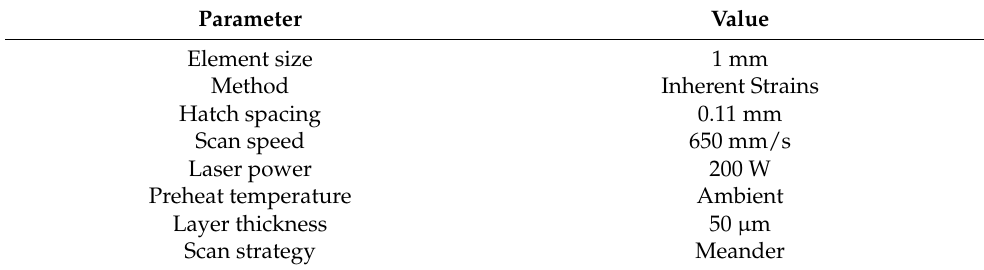
Table 2. Process parameters for input data in MSC Simufact.